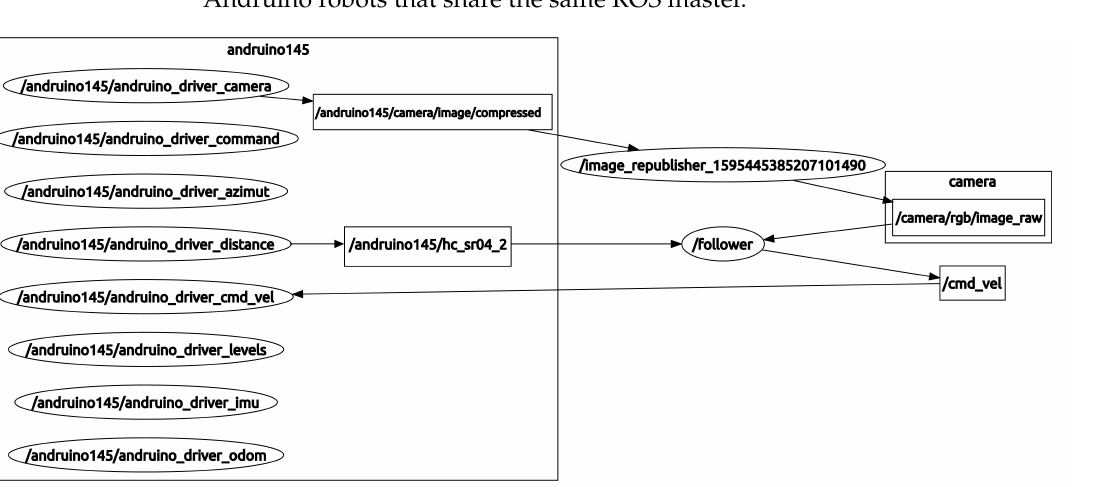
Figure 4. Andruino-R2 nodes and topics in a visual line-tracking task with obstacle